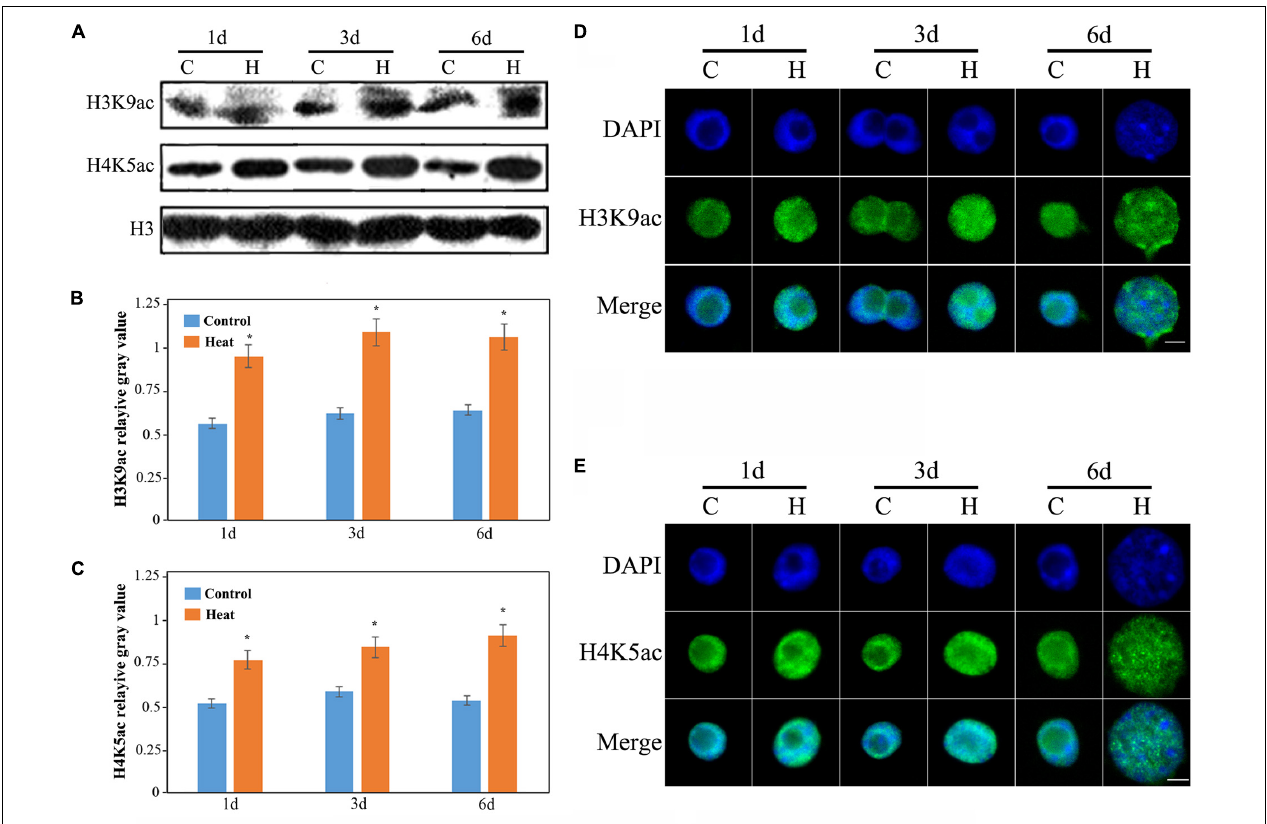
FIGURE 2 | Histone acetylation showed an increasing trend in the heat-induced inhibition of lateral root initiation in maize seedlings. (A) The levels of H3K9ac and H4K9ac in the roots of maize seedlings increased significantly under heat treatment. All the western blot assay were repeated three times, and histone H3 was used as the standard internal reference. (B) The mean gray value of H3K9ac bands. (C) The mean gray value of H4K5ac bands. (D) Immunological staining indicated an increase in the acetylation level of H3K9. (E) Immunologic staining showed an increase in the acetylation level of H4K5. The level of histone acetylation in the lateral root development of maize seedling was increased, and the nucleus was decondensed. Five hundred nuclei were observed in each sample. The Bar = 10 µ m. Asterisk ( ∗ ) indicated that the gene expression level of the heat treatment group which was found to be significantly different from that of the control group ( t -test, p <